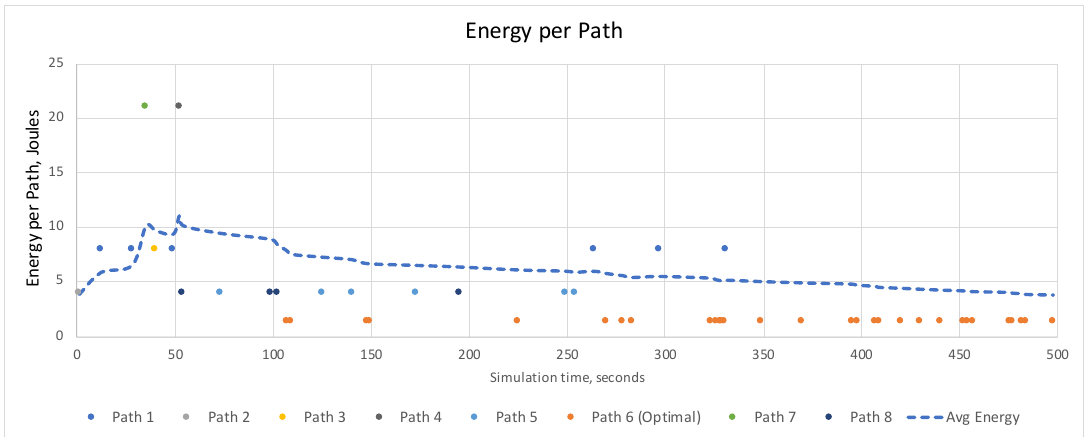
Figure 5. Energy per packet on every selected path in Adaptiveness Scenario,